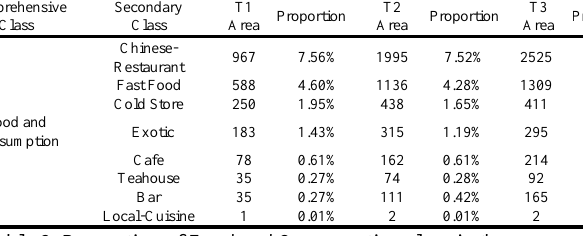
Table 2. Proportion of Food and Consumption class in three areas